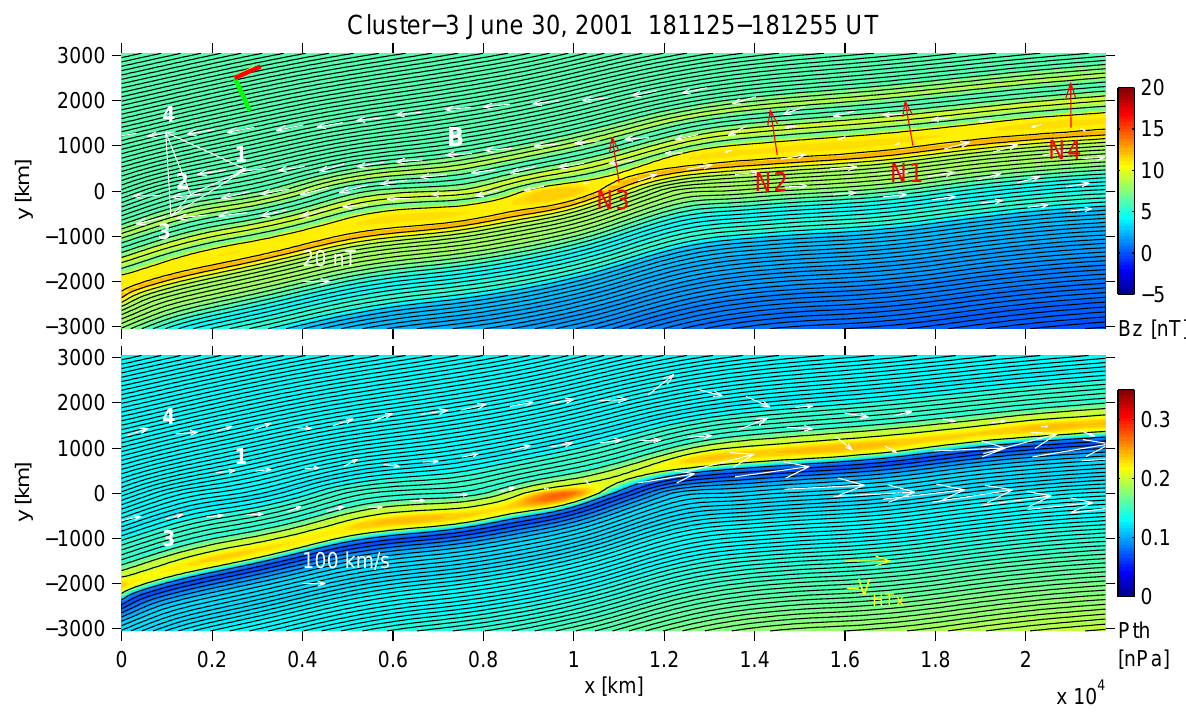
Fig. 5. Magnetic transect (top) and plasma pressure distribution (bottom) recovered by using a time-varying HT frame velocity for the C3 magnetopause crossing on 30 June 2001. The format and the spatial scale size are the same as in Fig.